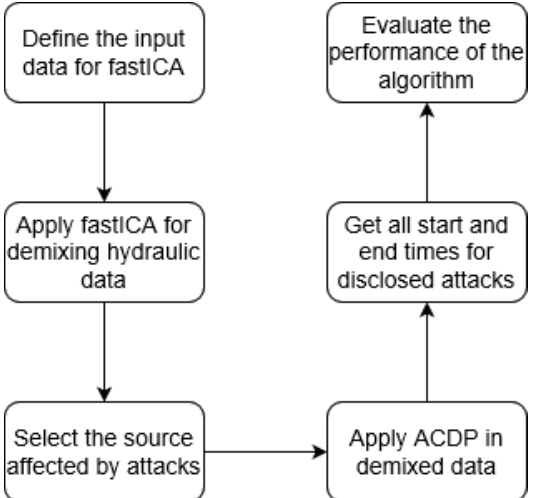
Figure 1. Flowchart of the complete methodology for disclosing cyber-attacks applying fastICA and ACPD